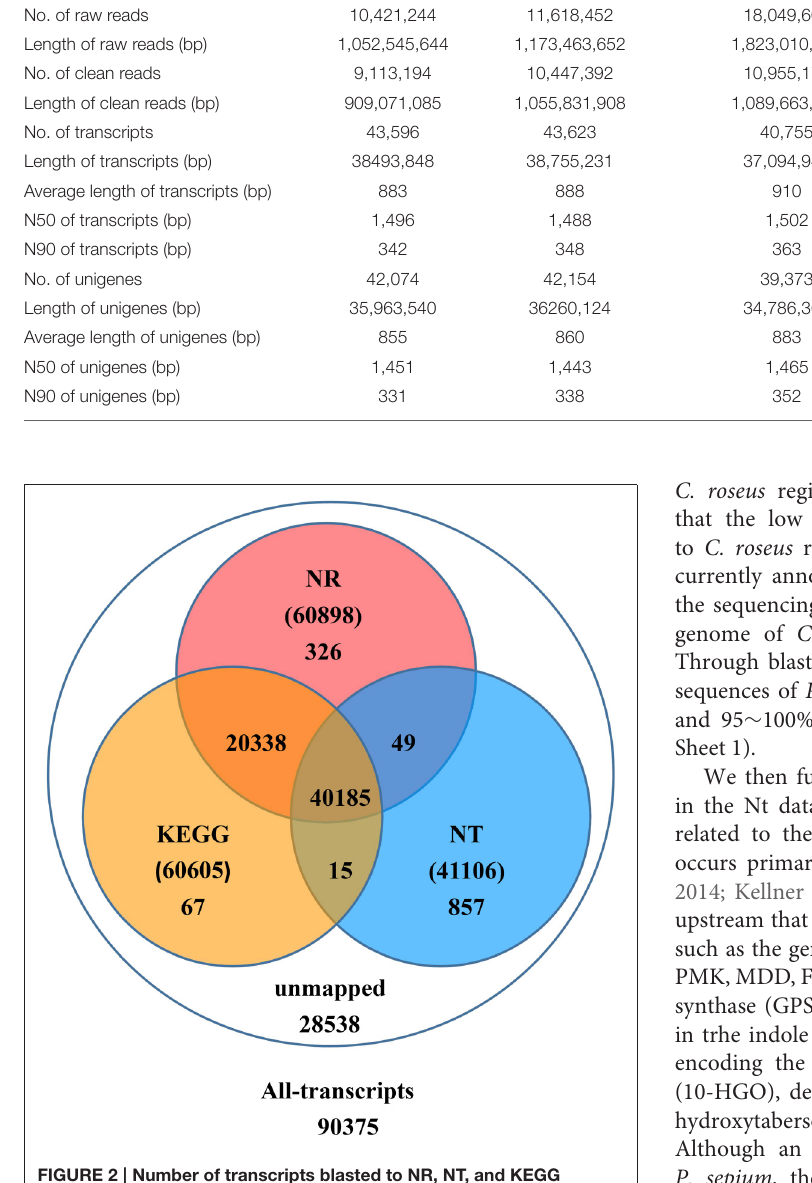
TABLE 2 | Summary of the Illumina sequencing and reads assembly for Periploca sepium . Leaves (L) Roots (R) Adventitious roots (AR) Calli (C) Four tissues together